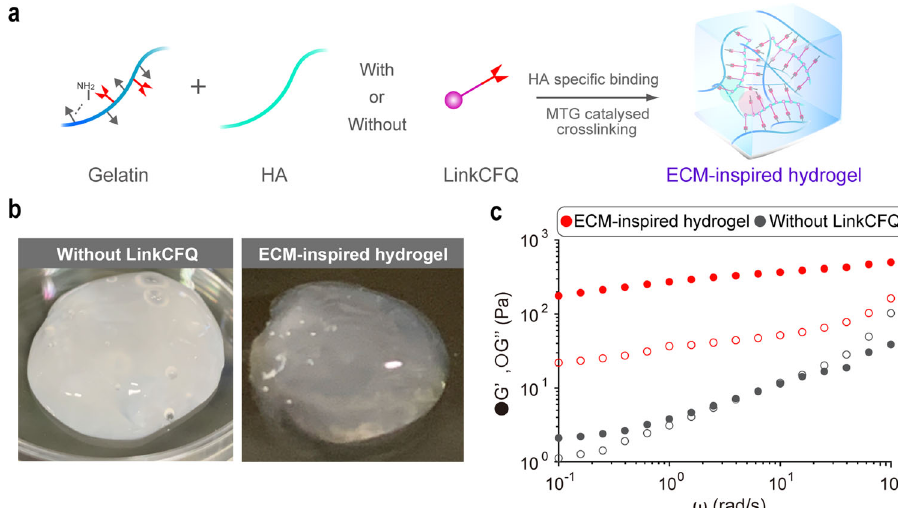
Fig. 5 Fabrication of ECM-inspired hydrogel with LinkCFQ. a Schematic illustration of ECM-inspired hydrogel formation. b Representative image of the fabricated ECM-inspired hydrogel. c Dynamic viscoelastic property of the fabricated ECM-inspired hydrogel. Glutamine and lysine residues are illustrated using red and gray graphics,